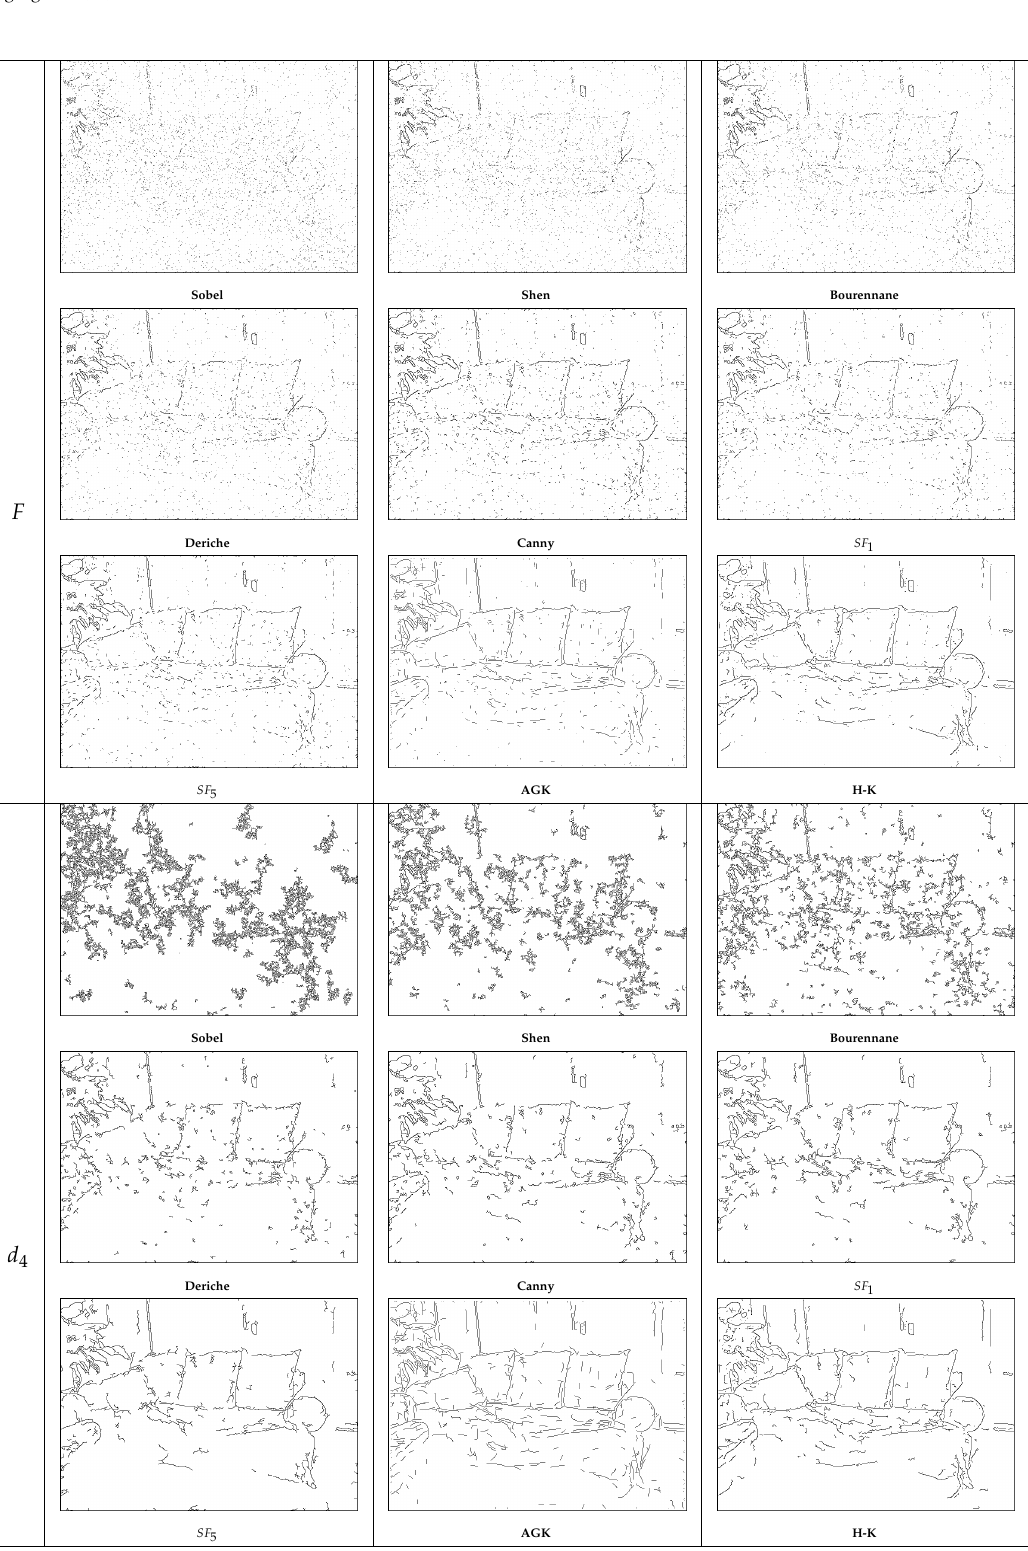
Figure 29. Ideal segmentations for several edge detectors on image 109, PSNR = 14